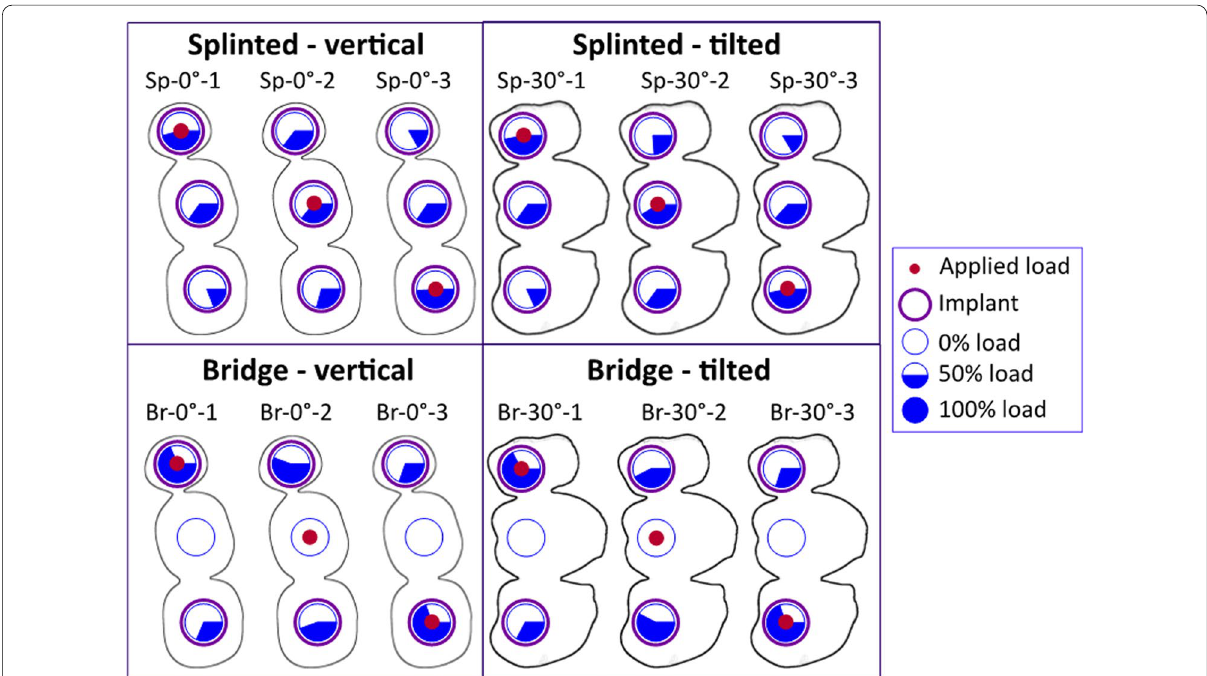
Fig. 4 Force distribution on splinted implants. The force effects are higher in the 2-implant configuration (bridge) compared to the loads distributed over 3 splinted implants for both loading directions